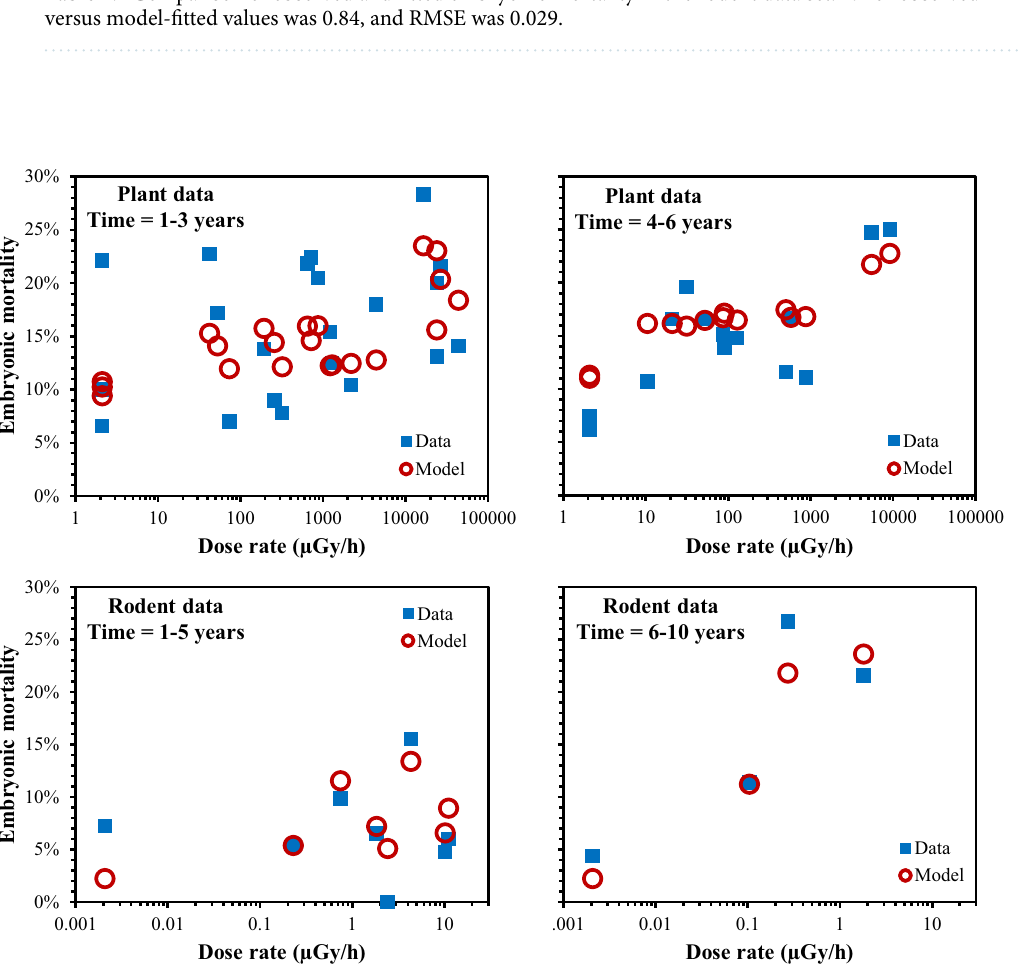
Figure 2. Comparison of observed data for plants ( Arabidopsis thaliana ) and rodents ( Clethrionomys glareolus ) with best-fit model predictions, as function of radiation dose rate and time after the Chernobyl accident. Model predictions are shown as symbols rather than as continuous curves because they do not change monotonically as function of dose rate measured at a given time after the accident, since they correspond to data from different locations with different dependences of dose rate on time (see Tables 1, 2). Continuous curves based on model predictions, which improve visualization of model behaviors, are shown in subsequent